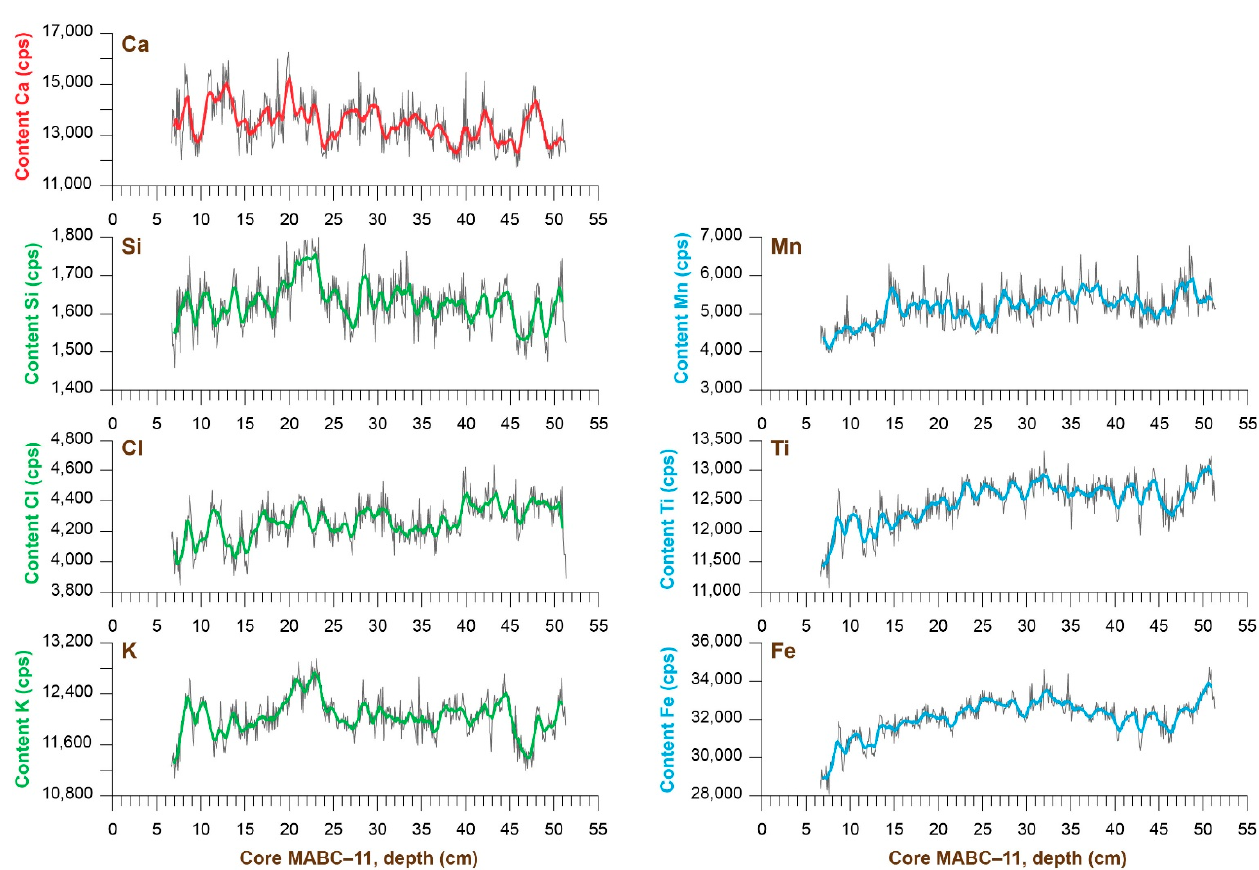
Figure 4. Changes in seven elements of core MABC–11 with nine-point average curves. Table 1. Correlation coefficients between chemical elements.